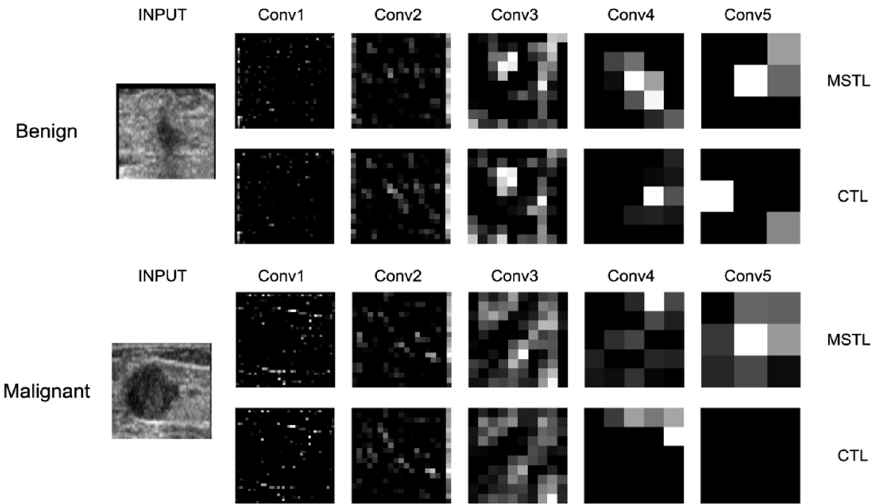
Figure 6. Feature extraction comparison via feature visualization of the five convolution layers of ResNet50 with the Adagrad optimizer for MSTL and CTL. Conv: convolution; MSTL: multistage transfer learning; CTL: conventional transfer learning.